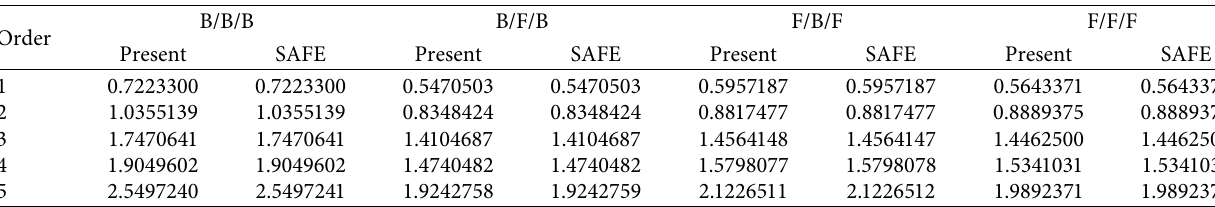
Table 2: At κ H � 2, the first five dimensionless frequencies Ω of the three-layered plate with different stacking sequence for this method and SAFE method.